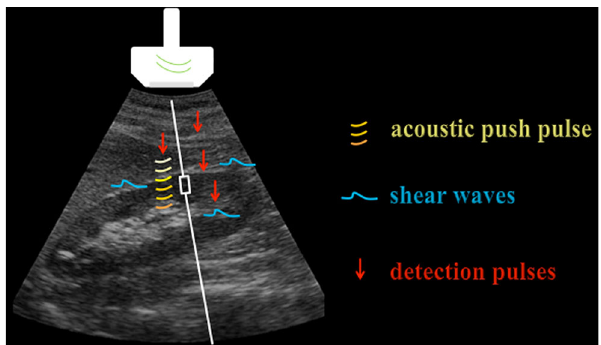
Fig. 1 Schematic representation of the ARFI technique. On a conventional gray-scale US image (oblique scan including the right kidney and the lowest portion of the right lobe of the liver), acoustic push pulses ( curved lines ) are generated together with the main US beam. From the push pulses originate shear waves ( dashed horizontal lines ) propagating perpendicular to the main US beam, which are sampled by tracking beams ( arrows ) parallel to the main beam. The actual distance covered by the shear waves before their attenuation is limited: the data concerning tissue response can only be achieved within a small ROI ( rectangular box along the straight vertical line )